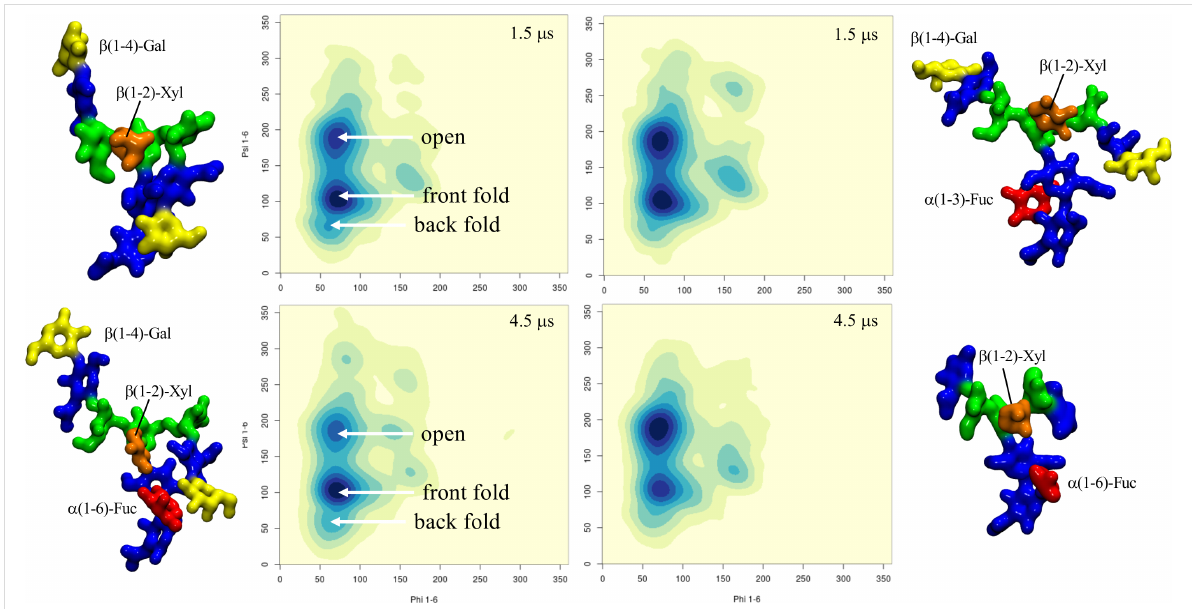
Figure 5: Conformational analysis of the (1-6) arm in four hybrid N-glycoforms, β (1-2)-xylosylated A2G2 (top-left), β (1-2)-xylosylated FA2G2 (bottom- left), β (1-2)-xylosylated α (1-3)-core fucosylated A2G2 (top-right) and β (1-2)-xylosylated FA2 (bottom-right). The predominant conformations are indi- cated in the top- and bottom-left heat maps for simplicity. The simulation time relative to each system is indicated in the top right corner of each heat map. The N-glycans structures are shown with the (1-3) and (1-6) arms on the left and on the right, respectively. The monosaccharides colouring follows the SFNG nomenclature. The structure rendering was done with VMD (https://www.ks.uiuc.edu/Research/vmd/) and the graphical statistical analysis with RStudio (https://www.rstudio.com).